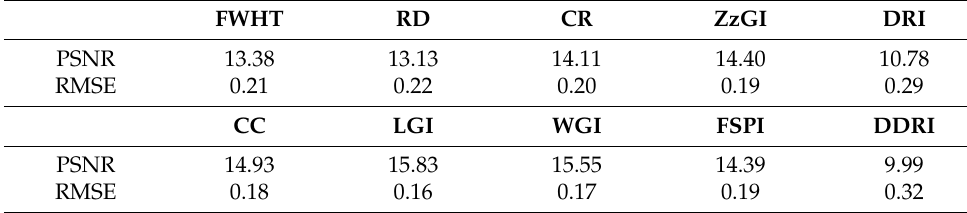
Table 6. PSNR and RMSE of images corresponding to the object “ 中 ” in Figure 9.